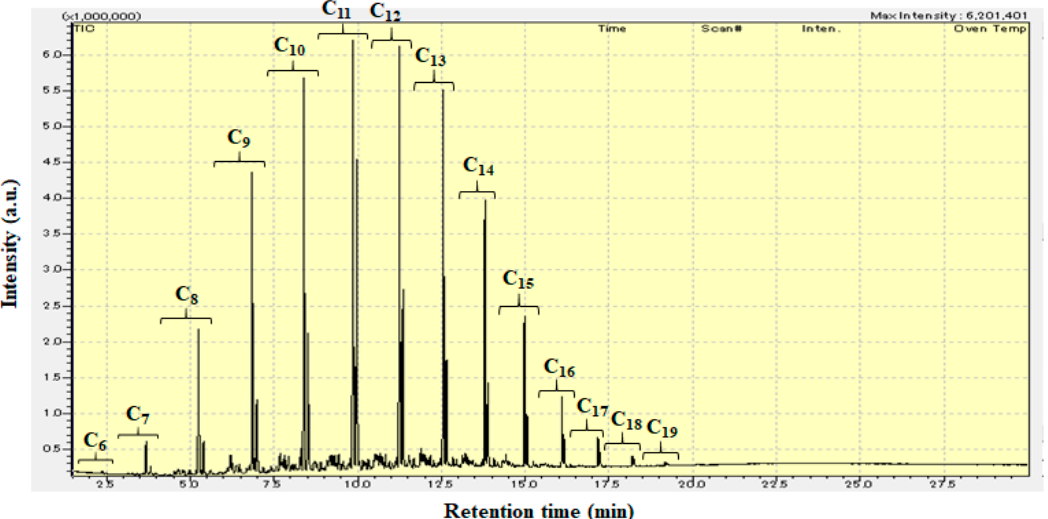
Figure 4. GC-MS chromatogram (retention time: 1.5–30 min) of liquid products from the hydrocracking of polyethylene over Pt/Al/MCM-48 at 573 K for 4 h.